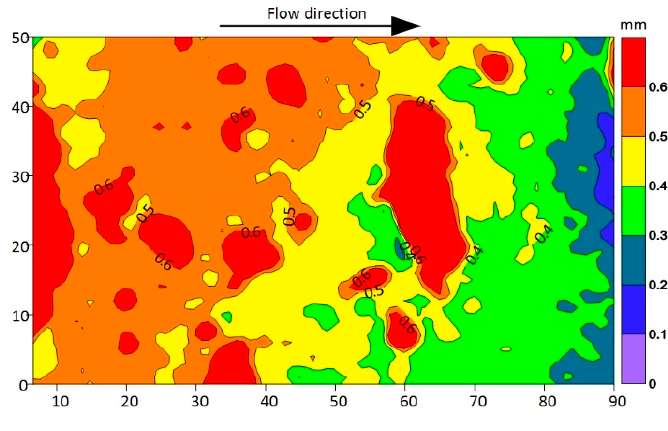
Figure 5. Fracture aperture contour.